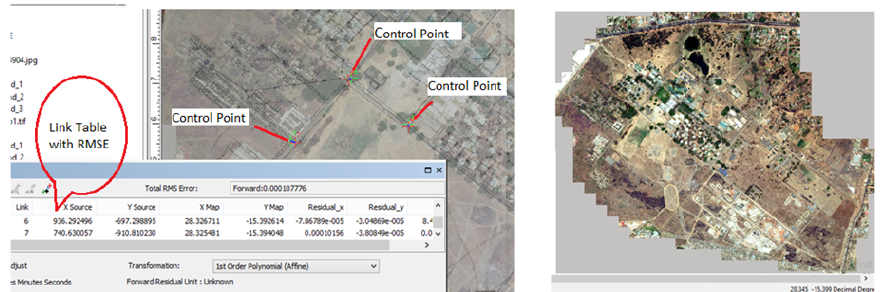
Fig. 6. Georeferenced control points and link table (Left), Georeferenced image in WGS84